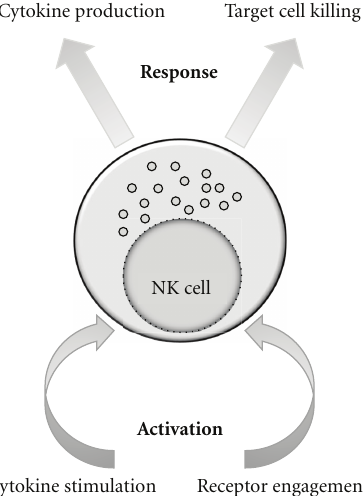
Figure 1: NK cells can be activated by inflammatory cytokines and/or NK-receptor ligand engagement. In turn, they can produce an array of cytokines or directly kill target